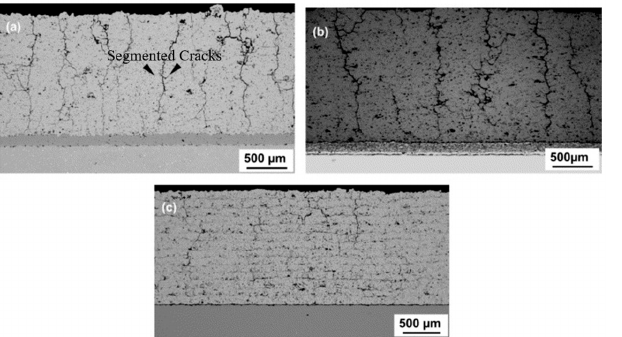
Figure 25. SEM micrographs of cross-section of as-sprayed YSZ-TTBCs, the segmentation crack den- sities of ( a – c ) are 2.7 mm − 1 crack density, 1.5 mm − 1 crack density and 0.9 mm − 1 crack density [118] .